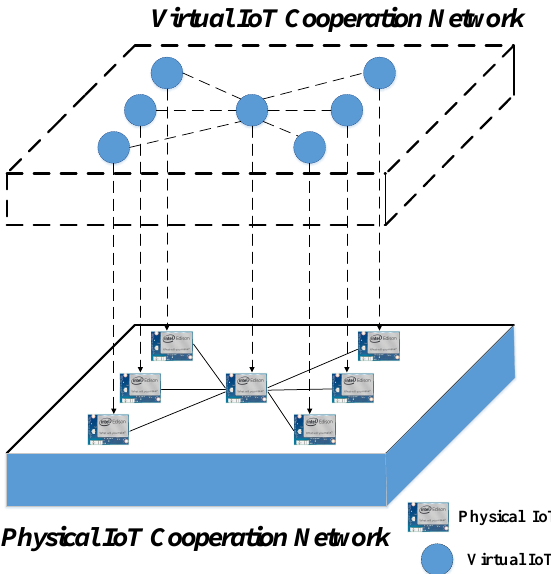
Figure 1. Mapping of cyber space to physical space.